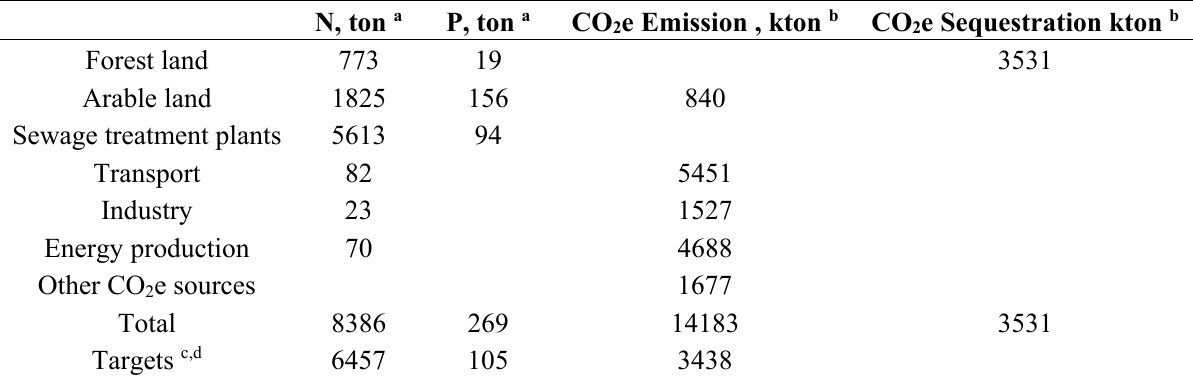
Table 1. Carbon dioxide equivalent (CO 2 e) emissions, and nitrogen (N) and phosphorus (P) leaching from different sources in the Stockholm-Mälar region into the Baltic